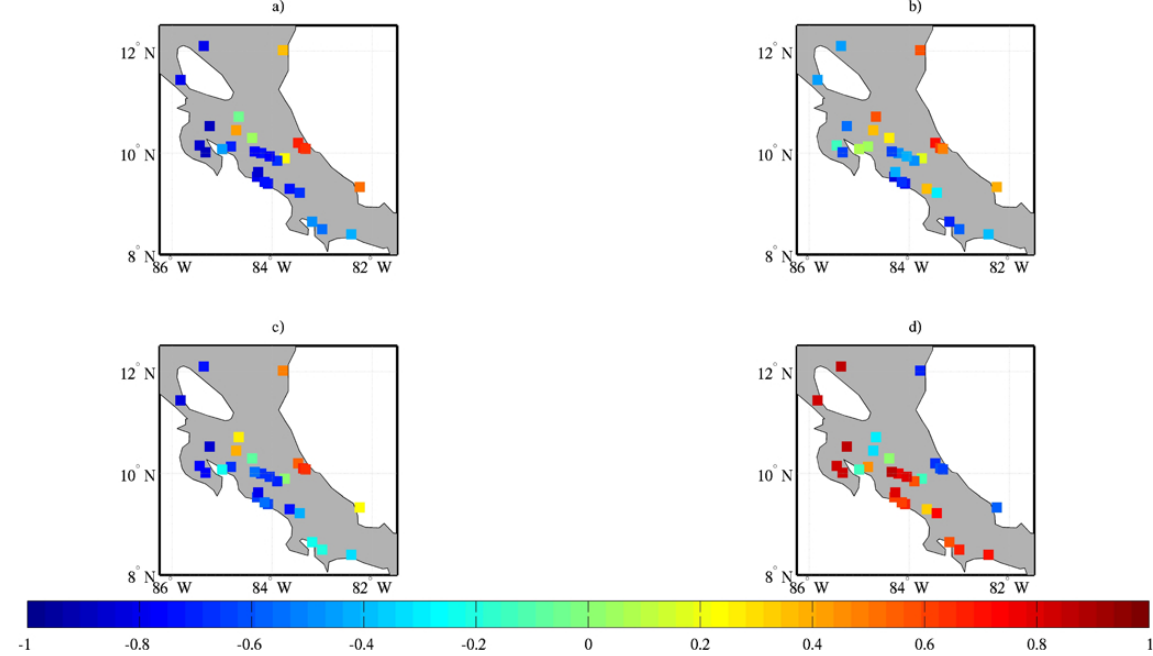
Fig. 5. ASO predictant spatial loadings (mode 1) of each model: (a) ACM, (b) FRD, (c) p80 and (d) p10.